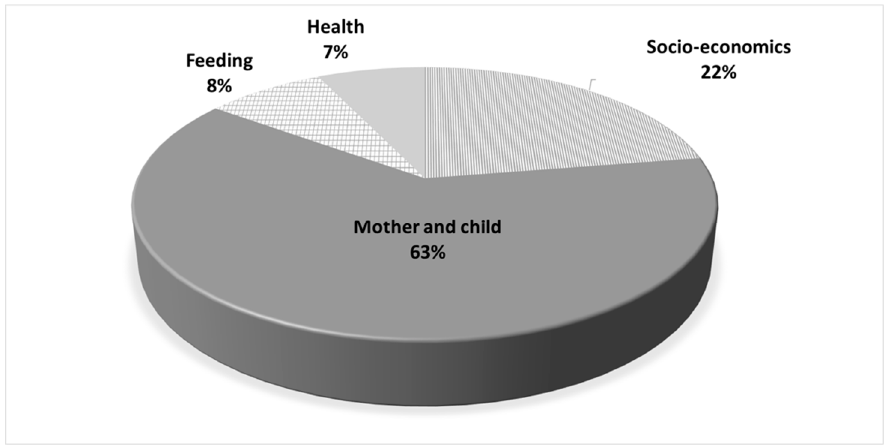
Figure 3. Contribution of individual level variables group to the incremental explanatory power of the regression (Pseudo R2).